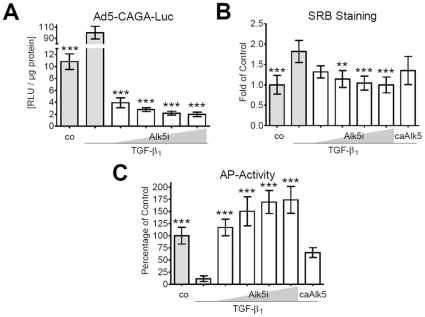
TGF-β1 mediated changes in primary human osteoblasts are Smad2/3-dependent.(A) Primary human osteoblasts (N = 4, n = 3) infected with Ad5-CAGA9-MLP-Luc reporter constructs (Smad2/4 reporter) were stimulated with 5 ng/ml hra TGF-β1 in the presence or absence of the Alk5 inhibitor SB431542 (5, 10, 20 and 40 nM). After 24 h luciferase activity was measured in cell lysates and normalized to total protein contents. (B/C) Primary human osteoblasts (N = 4, n = 4) were stimulated with 5 ng/ml hra TGF-β1 with or without the SB431542 (5, 10, 20, 40 nM) for 8 days or infected with Ad5-caAlk5 for 4 days. (B) Both TGF-β1 stimulation and caAlk5 infection increased proliferation (SRB staining) in primary human osteoblasts, which was inhibited dose-dependently by SB431542. (C) In the same line, AP activity, normalized to relative cell numbers, was decreased by TGF-β1 stimulation and infection with caAlk5. The decrease in AP-activity was blocked by SB431542 in a dose-dependent manner. Results are expressed as mean ± standard deviation. **p<0.01, ***p<0.001 in comparison to only TGF-β1 treated cells.